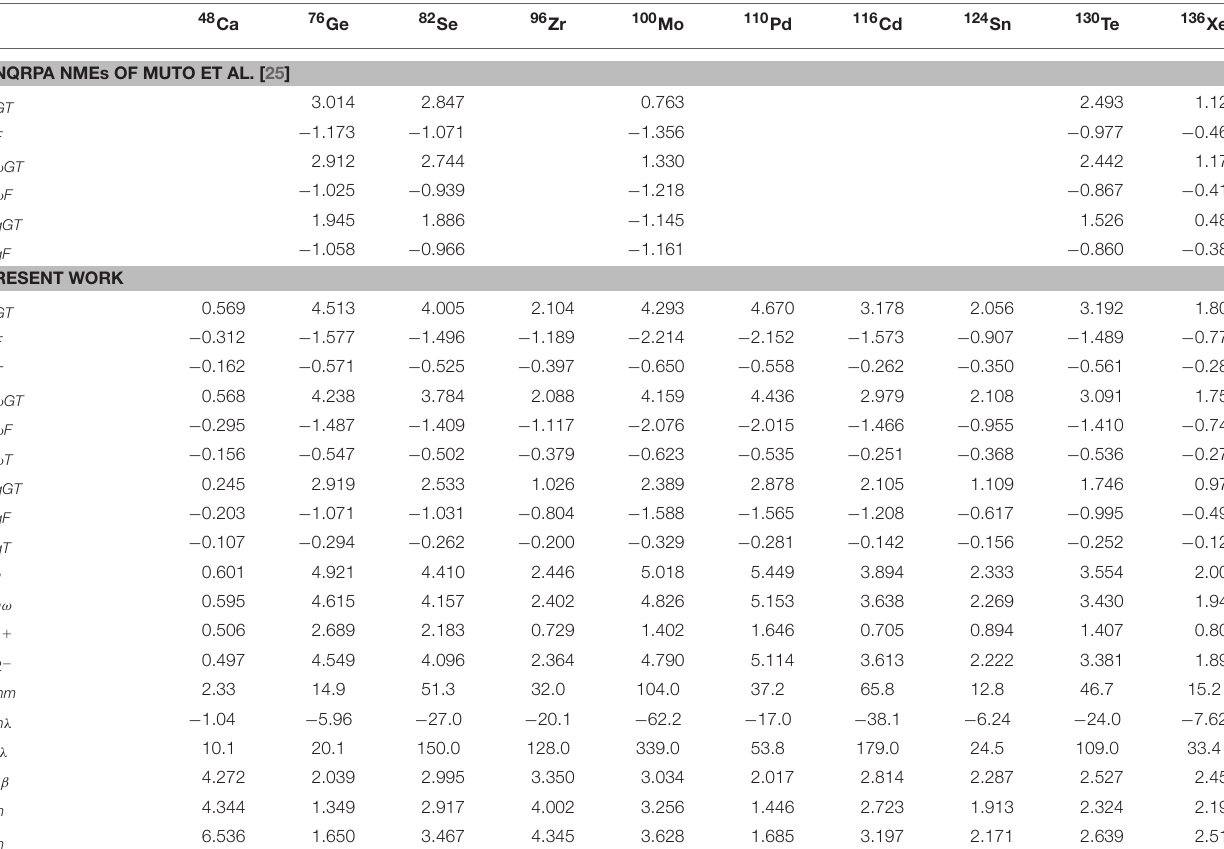
TABLE 1 | The nuclear matrix elements of the 0 νββ -decay associated with m ββ and λ mechanisms and the coefficients C mm , C m λ and C λλ (in 10 − 14 years − 1 ) of the decay rate formula (see Equation